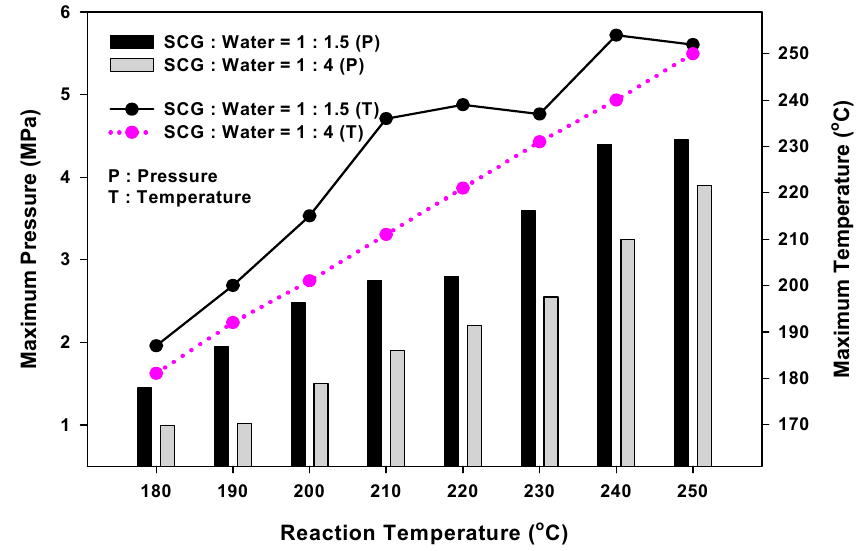
Figure 4. Change in pressure with reaction temperature for different water contents.